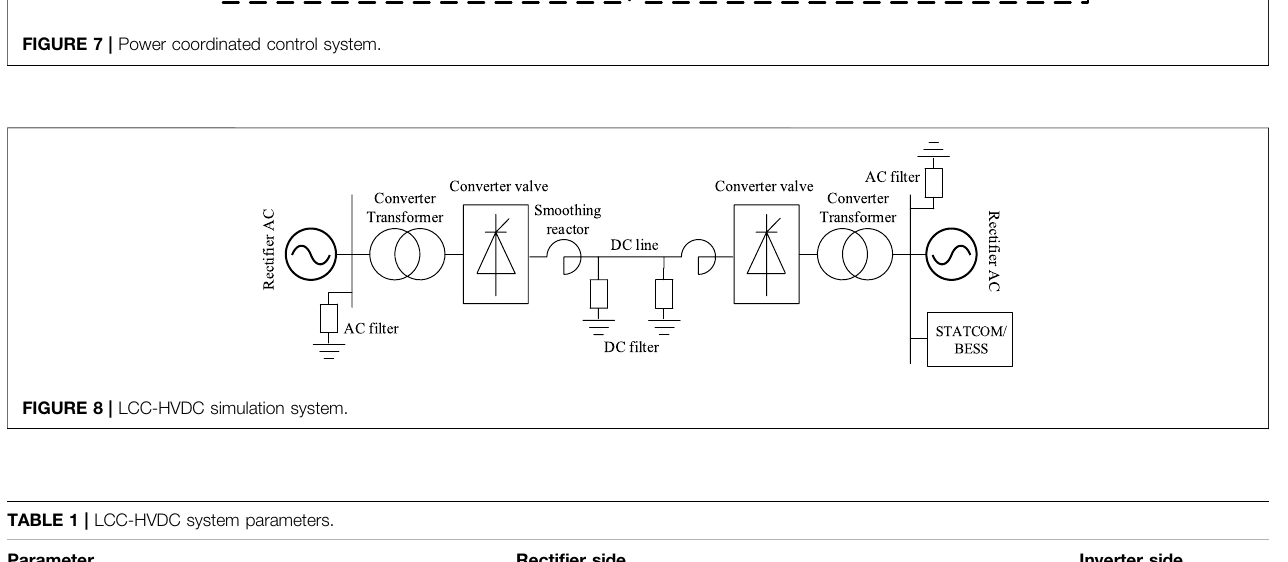
FIGURE 7 | Power coordinated control system.